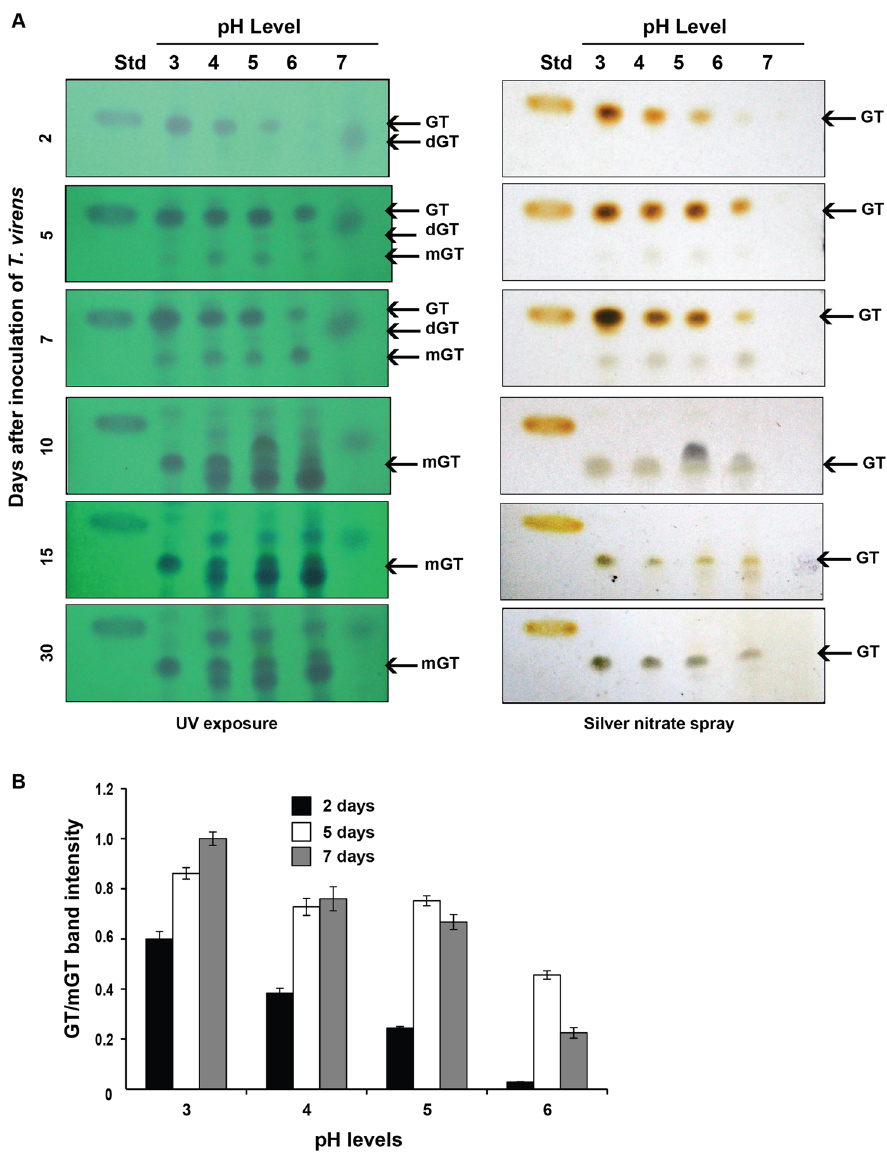
Figure 4. Stability of gliotoxin at different pH conditions. ( A ) T. virens culture was inoculated in Weindling medium buffered at different pH levels. The production and stability of gliotoxin were analysed at different time of incubation as described in Fig. 2A. GT gliotoxin, mGT Bis-thiomethyl gliotoxin; dGT-degraded gliotoxin, Std standard gliotoxin. ( B ) The levels of gliotoxin (GT) production by T. virens were measured by densitometry analysis. Gliotoxin band intensity values were normalized with respect to the highest intensity considered as